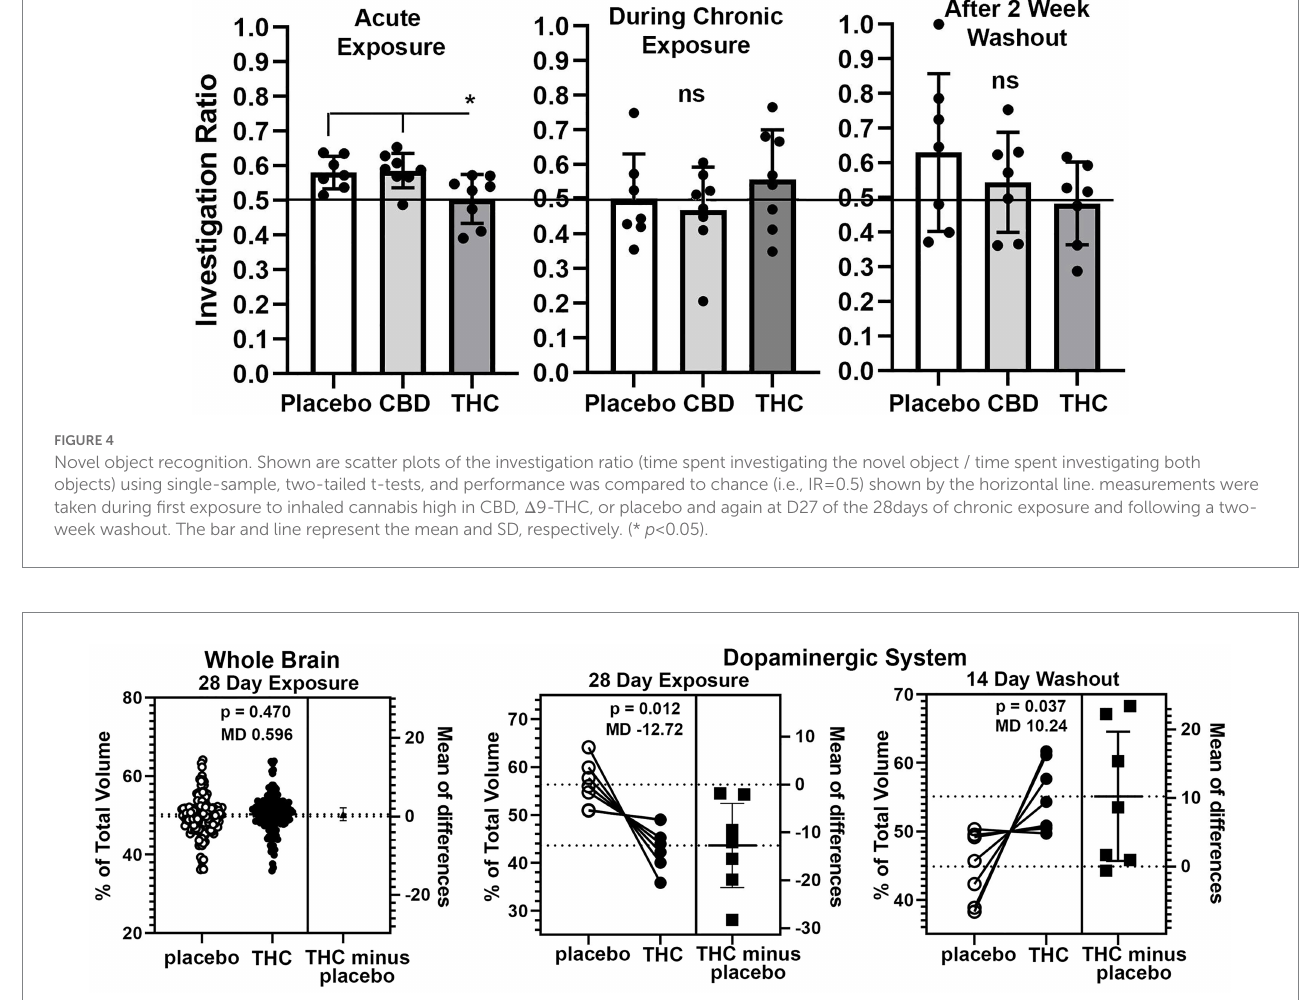
AUDP, placebo vs. CBD, p = 0.02), somatosensory cortex (L SSC1,